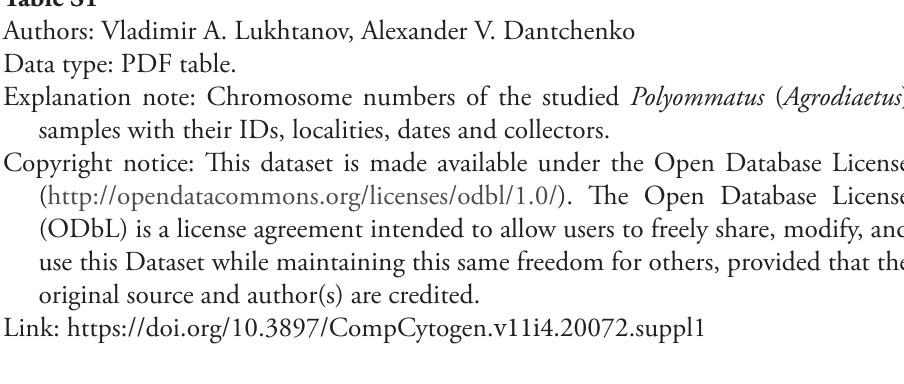
Authors: Vladimir A. Lukhtanov, Alexander V. Dantchenko Data type: PDF